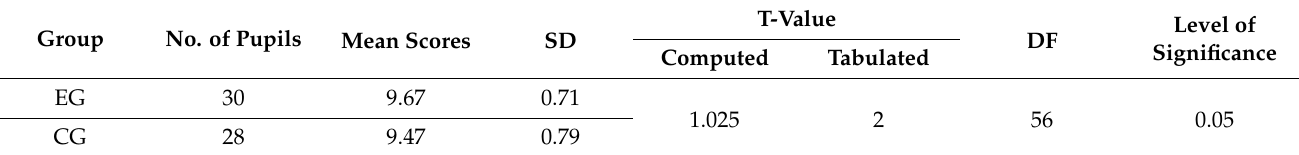
Table 12. The Mean Scores, Standard Deviations, and T-Values of the EG and CG in the Second Posttest.